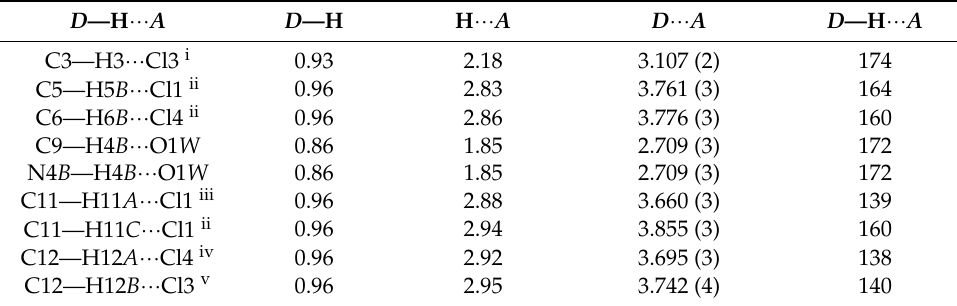
Figure 5. Representation of hydrogen bonds in the structure of ( 2 ). Table 5. Hydrogen-bond geometry (Å, ◦ ) in complex ( 2